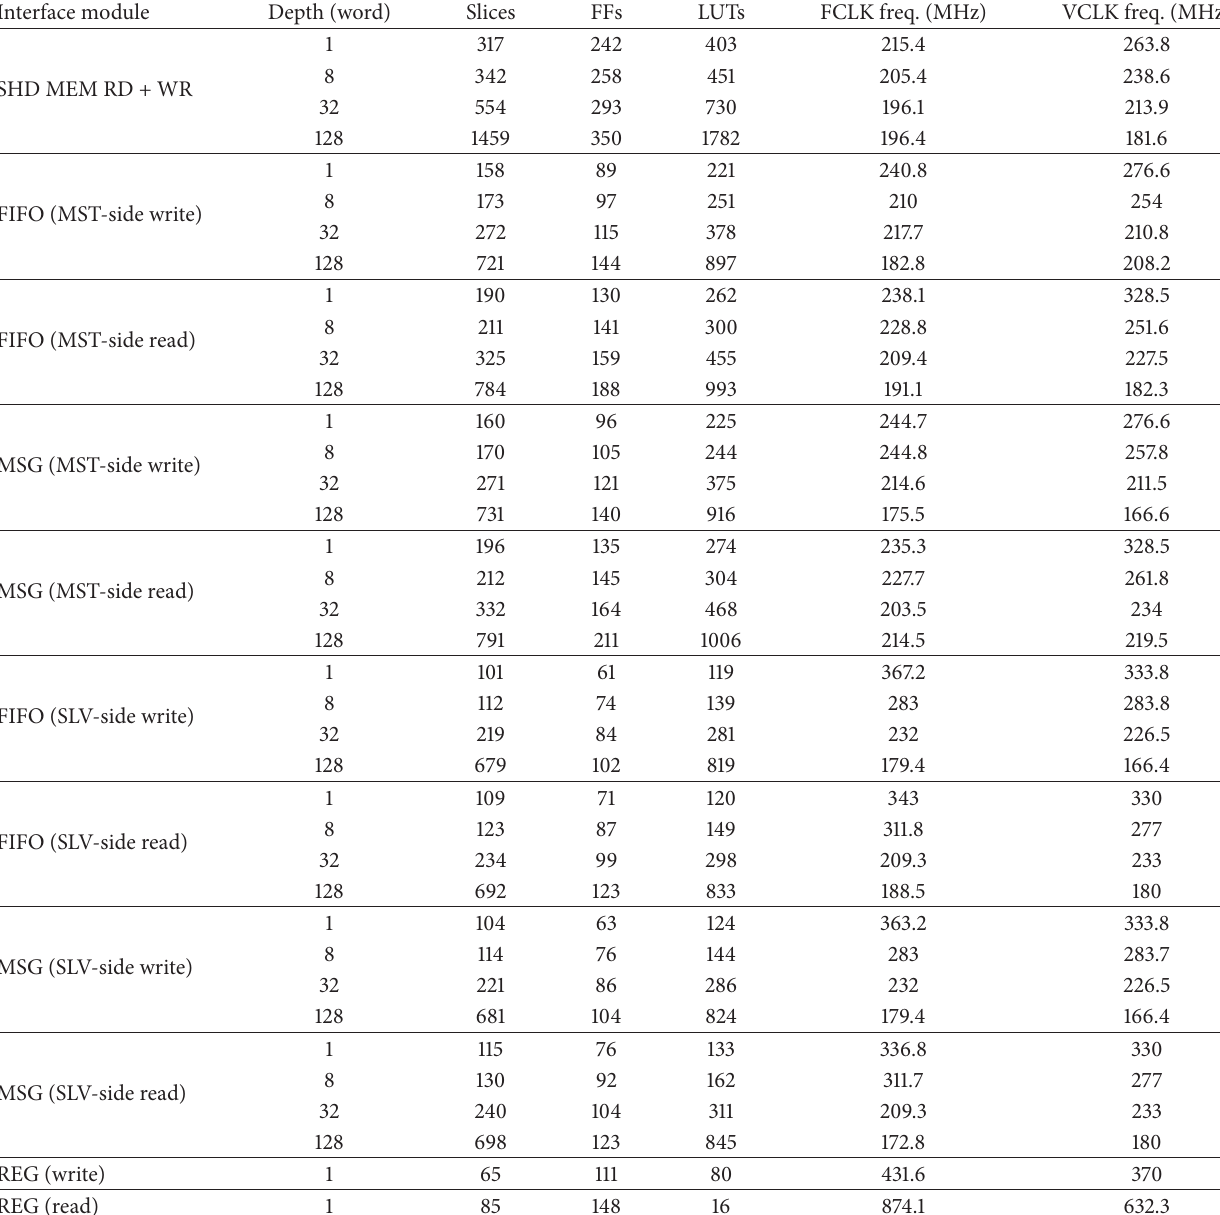
Table 6: Communication Channels’ HW Interface Modules—synthesis